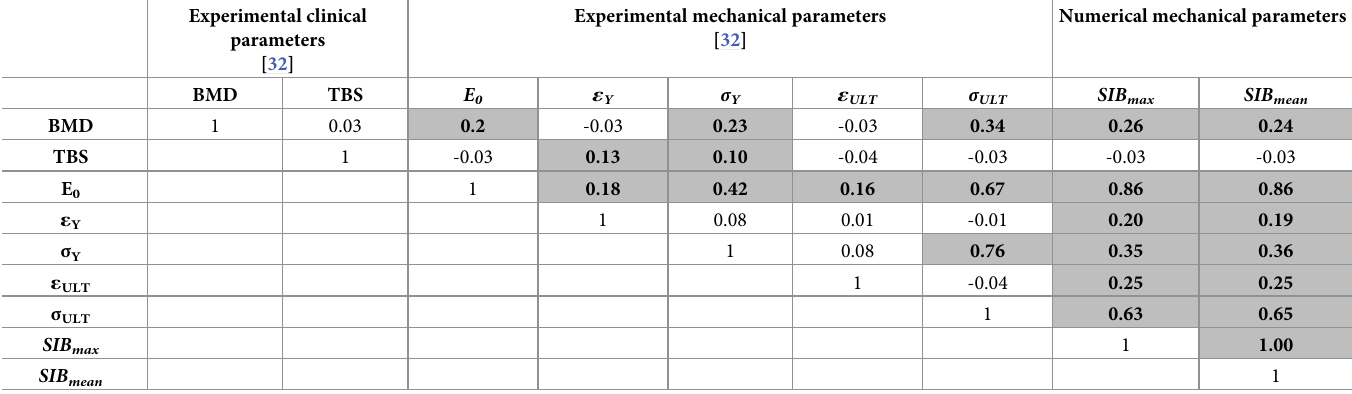
Table 1. Adjusted linear determination coefficients ( R 2 ) between the numerical SIB max and SIB mean , and the experimental clinical and mechanical parameters. adj Grey-coloured cells represent a significant linear correlation, with p-value < 0.05.